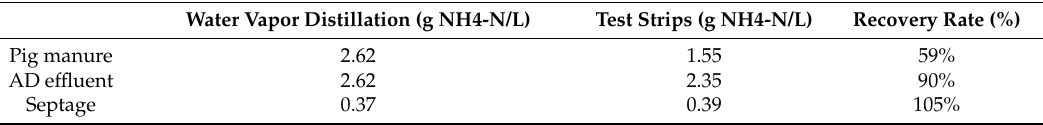
Table A12. Comparison water-vapor distillation vs. test